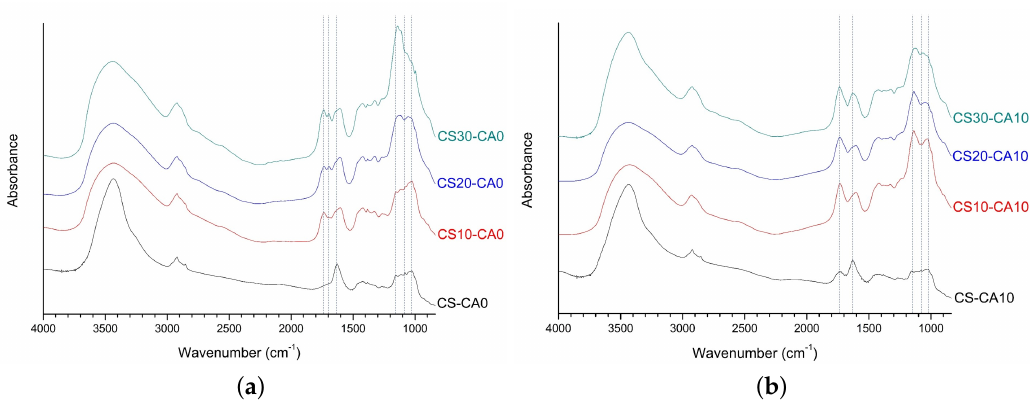
Figure 3. The FT-IR spectra of polysaccharide-based SAPs: ( a ) CS-CA0, CS10-CA0, CS20-CA0, CS30-CA0; ( b ) CS-CA10, CS10-CA10, CS20-CA10,